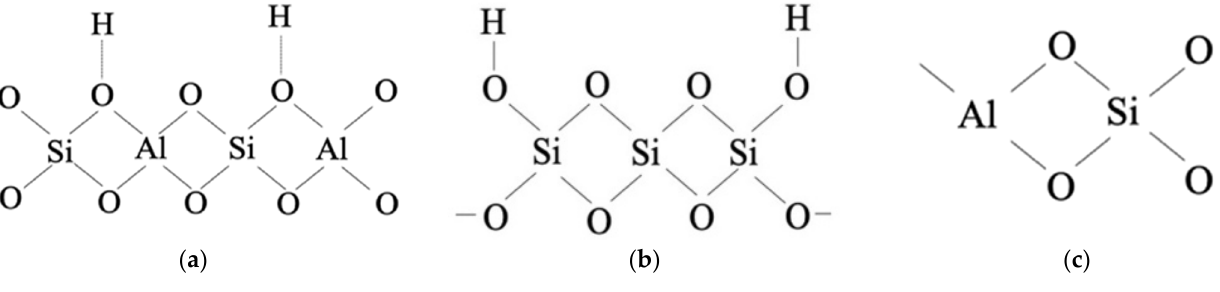
Figure 12. The structure of the bridge ( a ) and silanol ( b ) Brønsted and Lewis sites ( c ). Their ratio can be changed by varying the processing modes (temperature, environ- mental conditions, and heating duration) of zeolites [154], as well as by modifying [155]. Catalytic systems based on HZSM zeolites with various silicate modules (Si/Al = 12, 25, 40), both initial and modified with nanosized anatase (NA/HZSM-1 and NA/HZSM-2) have been proposed for the propane and ethanol conversion.